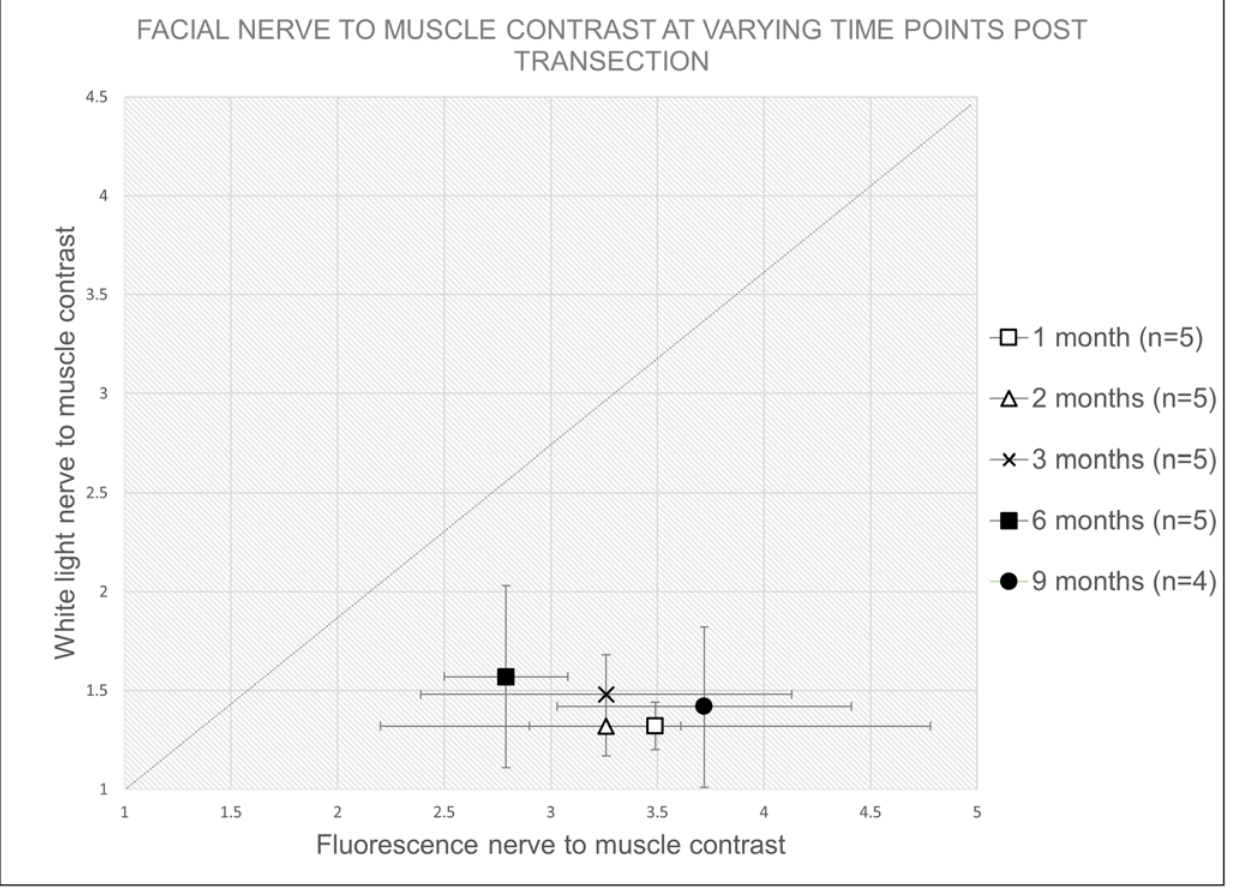
Fig 2. Plot of intensity ratios (mean and 95% CIs) showing improved visualization with F-NP41 labeling compared to white light reflectance of degenerated nerves at different time points after transection. Equal reflectance versus fluorescence is indicated by the dashed line (slope = 1). Values to the right of the line indicate an improved visualization with fluorescence imaging compared to white light, which was achieved at all measurement time points.